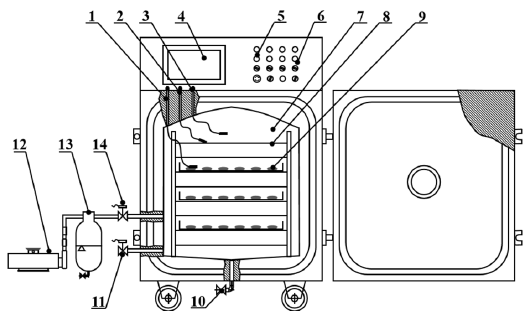
Figure 3. Structure diagram of pulsed vacuum drying equipment. (1) Material temperature sensor, (2) infrared-board temperature sensor, (3) pressure sensor, (4) touch screen control panel, (5) indicator light, (6) adjusting switch, (7) drying chamber, (8) far-infrared radiation heating element, (9) samples, (10) drain solenoid valve, (11) air solenoid valve, (12) vacuum pump, (13) condenser, (14) vacuum valve.